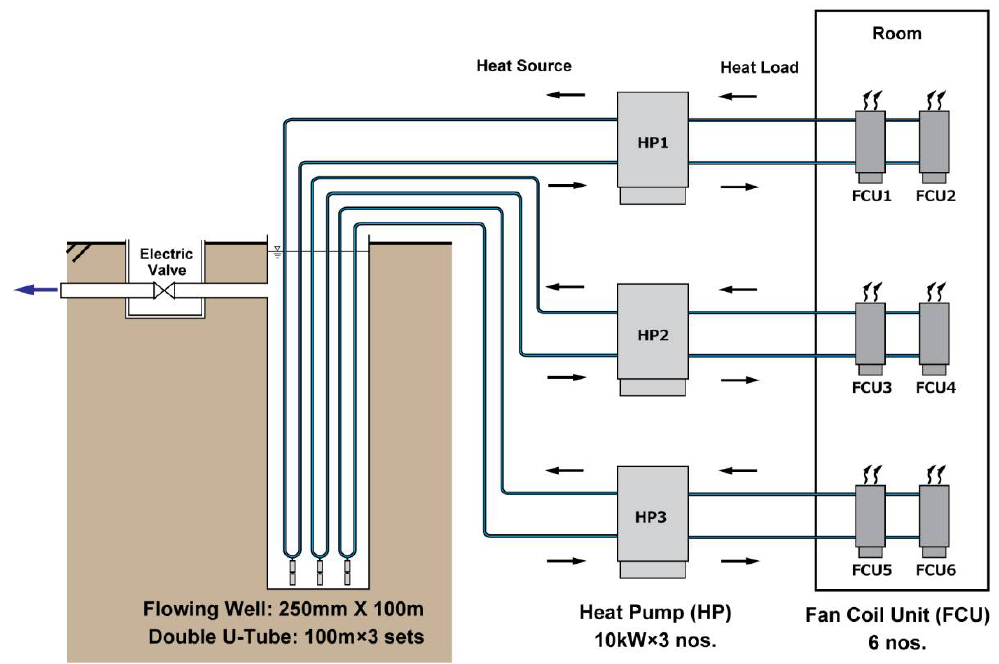
Figure 10. Ground source heat pump (GSHP) system using an artesian well. Reprinted by permission from Springer Customer Service Centre GmbH: Springer HYDROGEOLOGY JOURNAL (Performance evaluation of a ground-source heat pump system utilizing a flowing well and estimation of suitable areas for its installation in Aizu Basin, Japan, Shrestha et al., 2017).